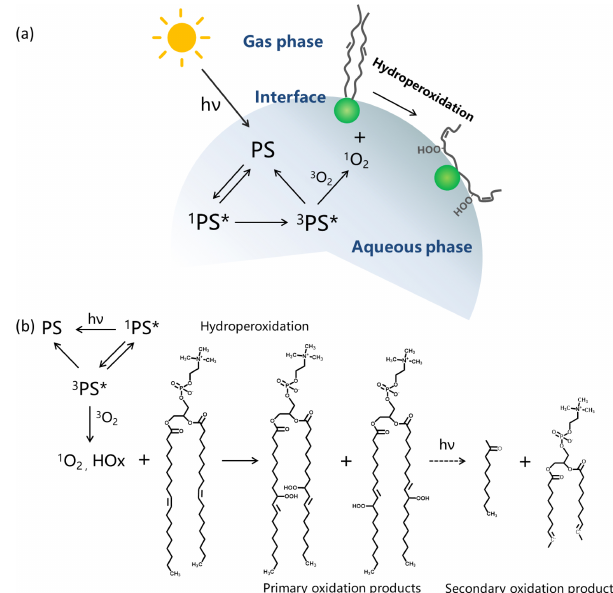
Figure 6. (a) Proposed model for DOPC–photosensitizer (PS) in- teraction at the air–aqueous interface. (b) Possible/proposed mech- anism for the photo-induced oxidation of DOPC in the presence of the photosensitizer